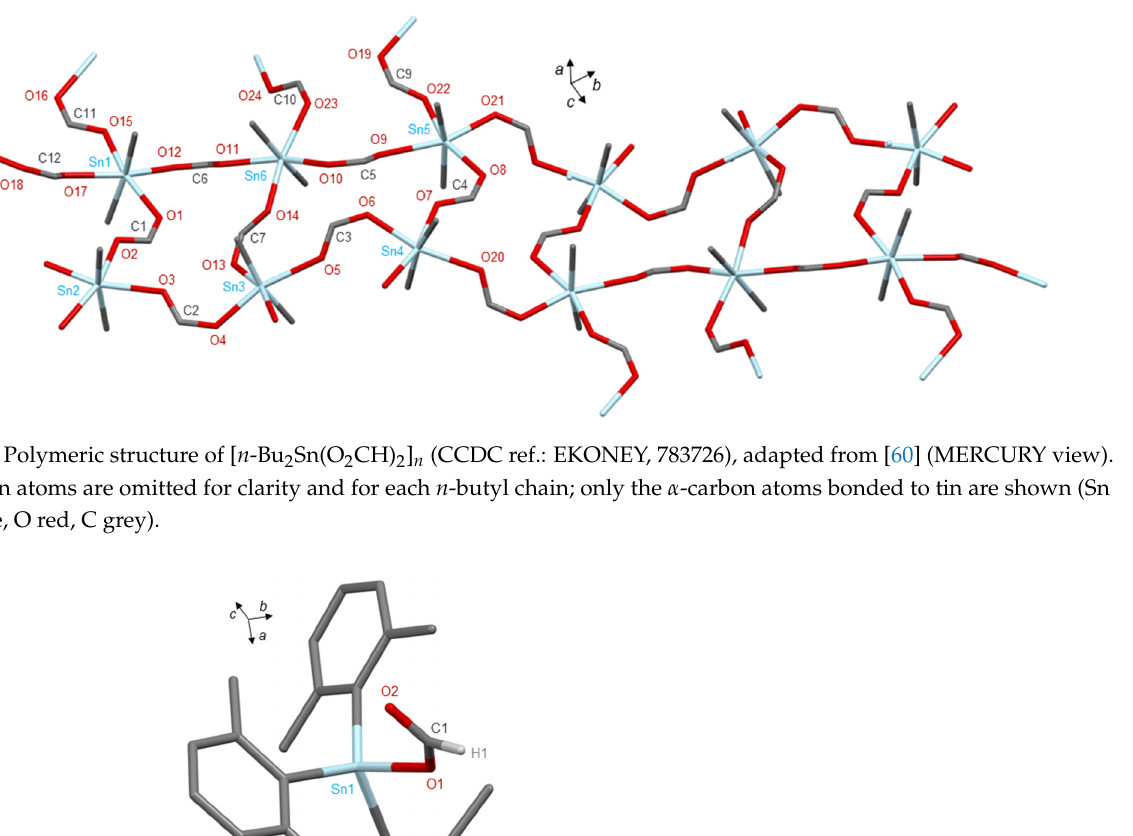
Figure 7. Infinite sheets based-structure of [Me 2 Sn(O 2 CH) 2 ] n (CCDC ref.: SIFLEY, 1258788), adapted from [59] (MERCURY view). Hydrogen atoms are omitted for clarity (Sn light blue, O red, C grey).